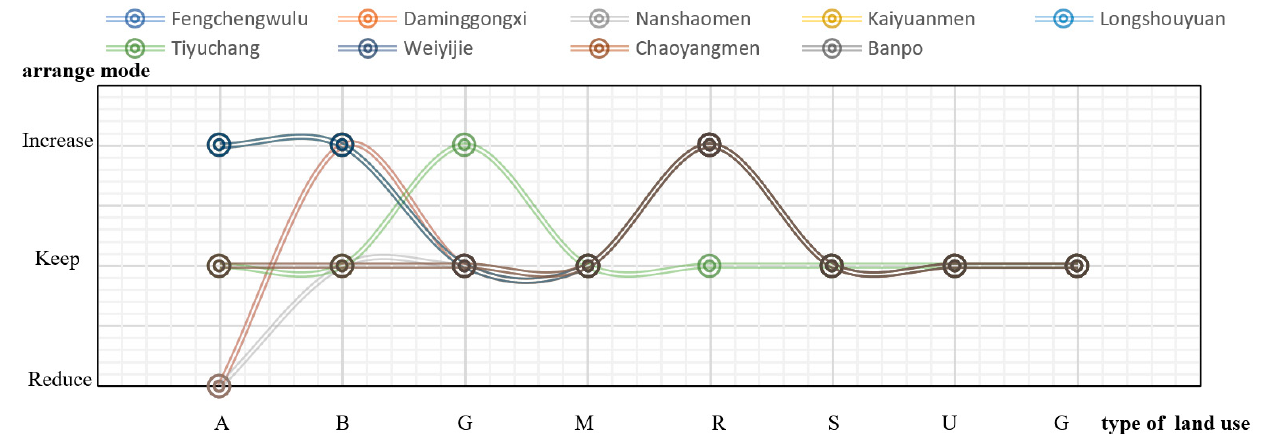
Figure 5. Areas with low development intensity; diagram of the optimization plan for the develop- ment intensity of each station.